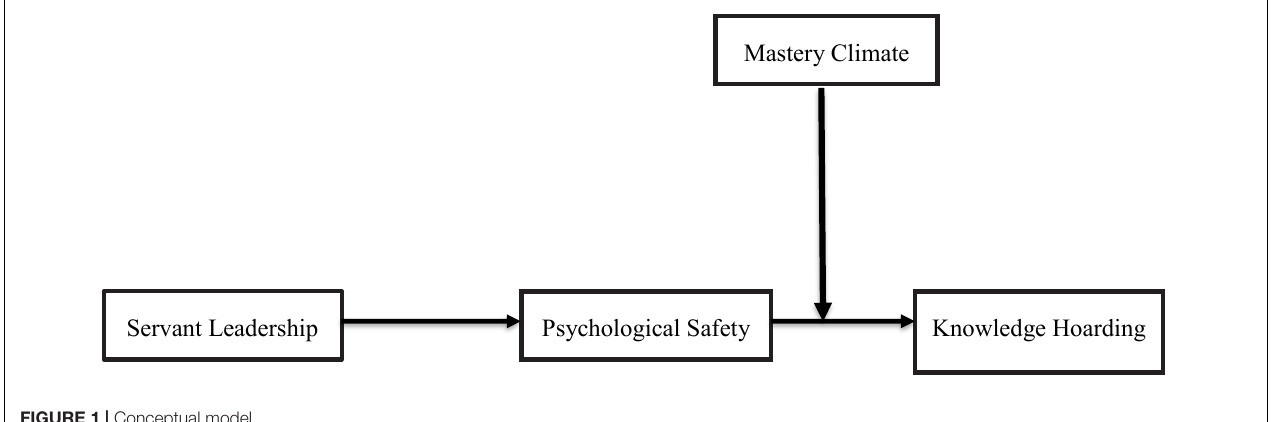
FIGURE 1 | Conceptual